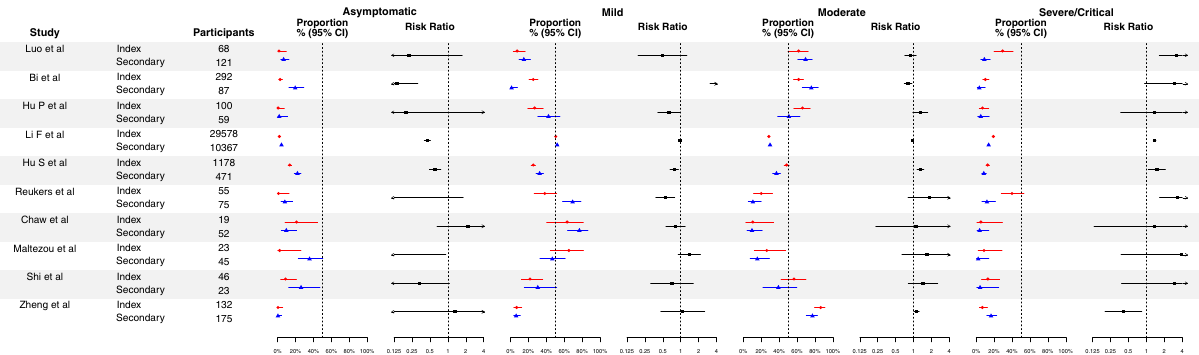
Fig. 3 Reported case severity, including proportion of asymptomatic, mild, moderate and severe of critical for COVID-19 for index cases and secondary cases, and their corresponding risk ratio of index cases verse secondary cases. Red circles and lines indicate the proportion of fever of index cases and the corresponding 95% exact binomial con fi dence intervals. Blue triangles and lines indicate the proportion of fever of secondary cases and the corresponding 95% con fi dence intervals. Black squares and lines indicate the risk ratio of proportion of fever of index cases compared with secondary cases and the corresponding 95% con fi dence intervals calculated based on normal approximation. All statistical tests are two-sided tests. Adjustments are not made for multiple